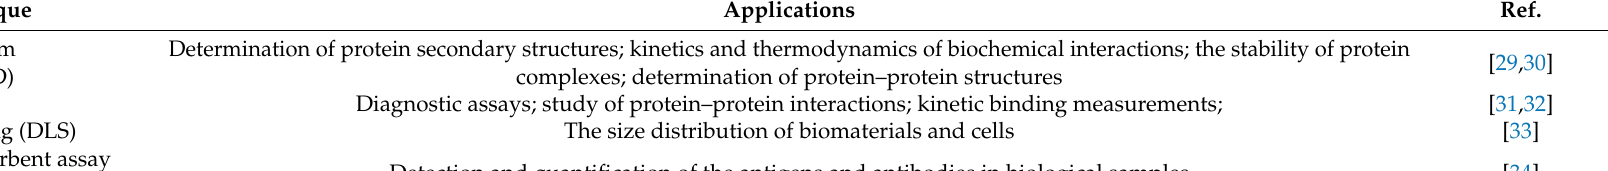
Table 1. Different analytical techniques for the characterization of biochemical